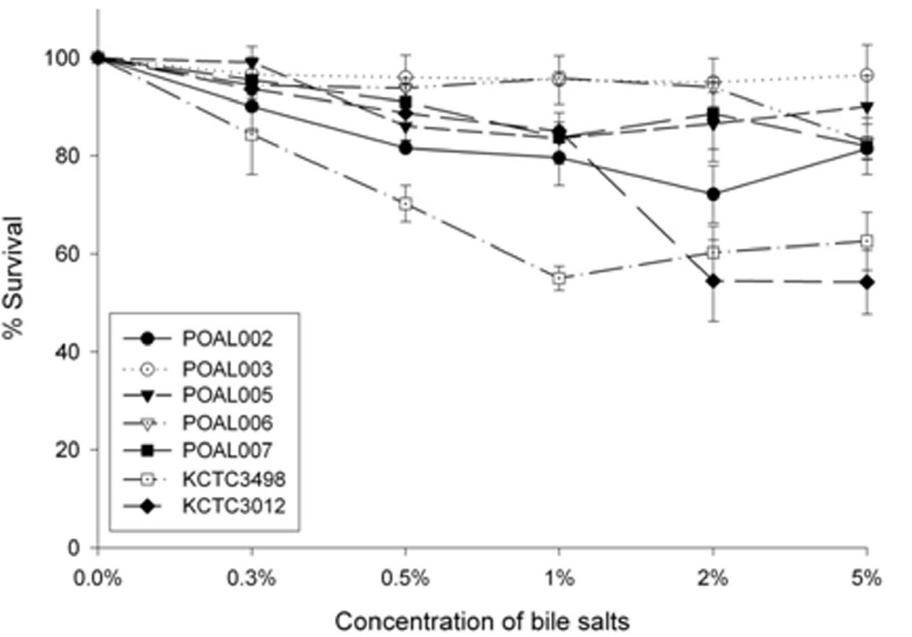
Table 3. Antibiotic susceptibility profiles of the POAL strains*.